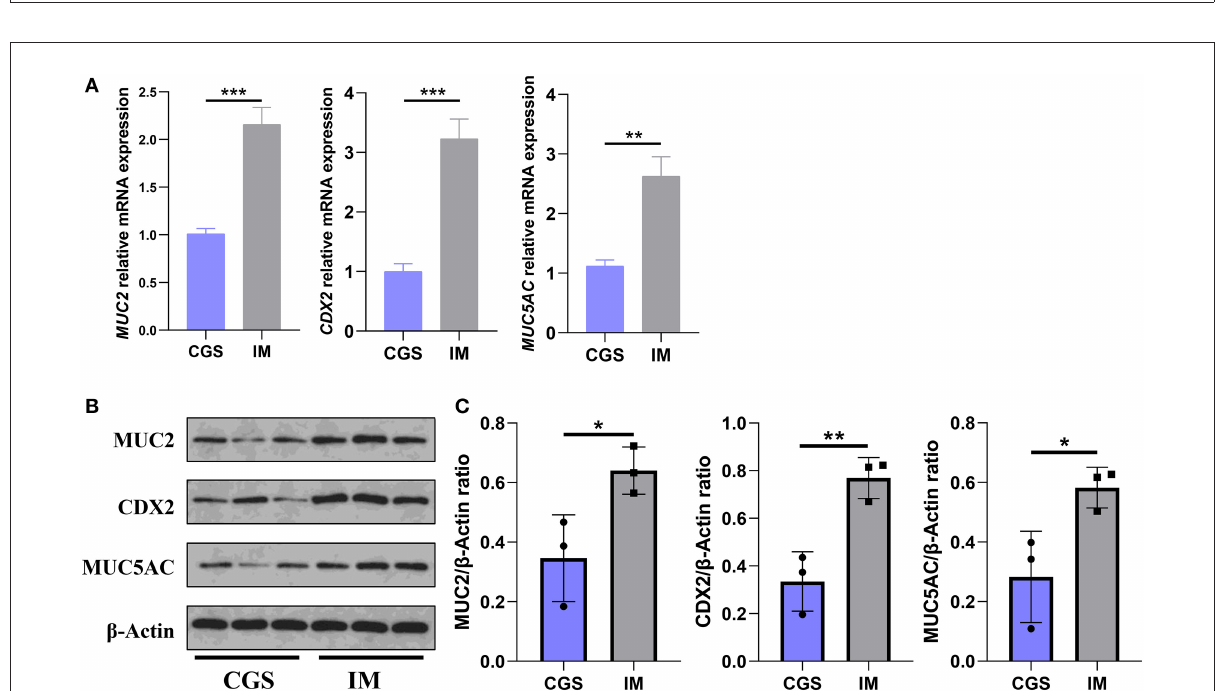
FIGURE2 Differences in the expression of MUC2, MUC5AC, and CDX2 in gastric antral mucosa of patients with CSG and IM. (A) qRT-PCR results of MUC2 , MUC5AC, and CDX2 in Gaussian antral mucosa of patients with CSG and IM. (B,C) Western blot results of MUC2, MUC5AC, and CDX2 in Gaussian antral mucosa of patients with CSG and IM. Asterisks denote significance (* p < 0.05; ** p < 0.01; *** p <